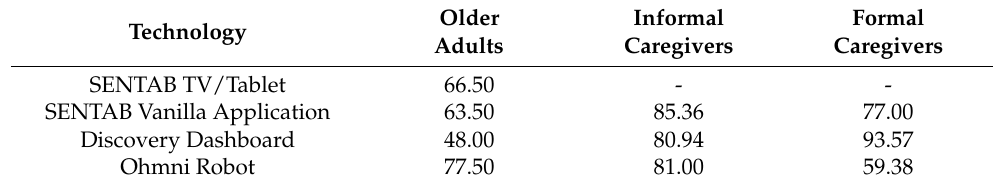
Table 7. The mean of the SUS results in Phase 1 of pre-validation among the user